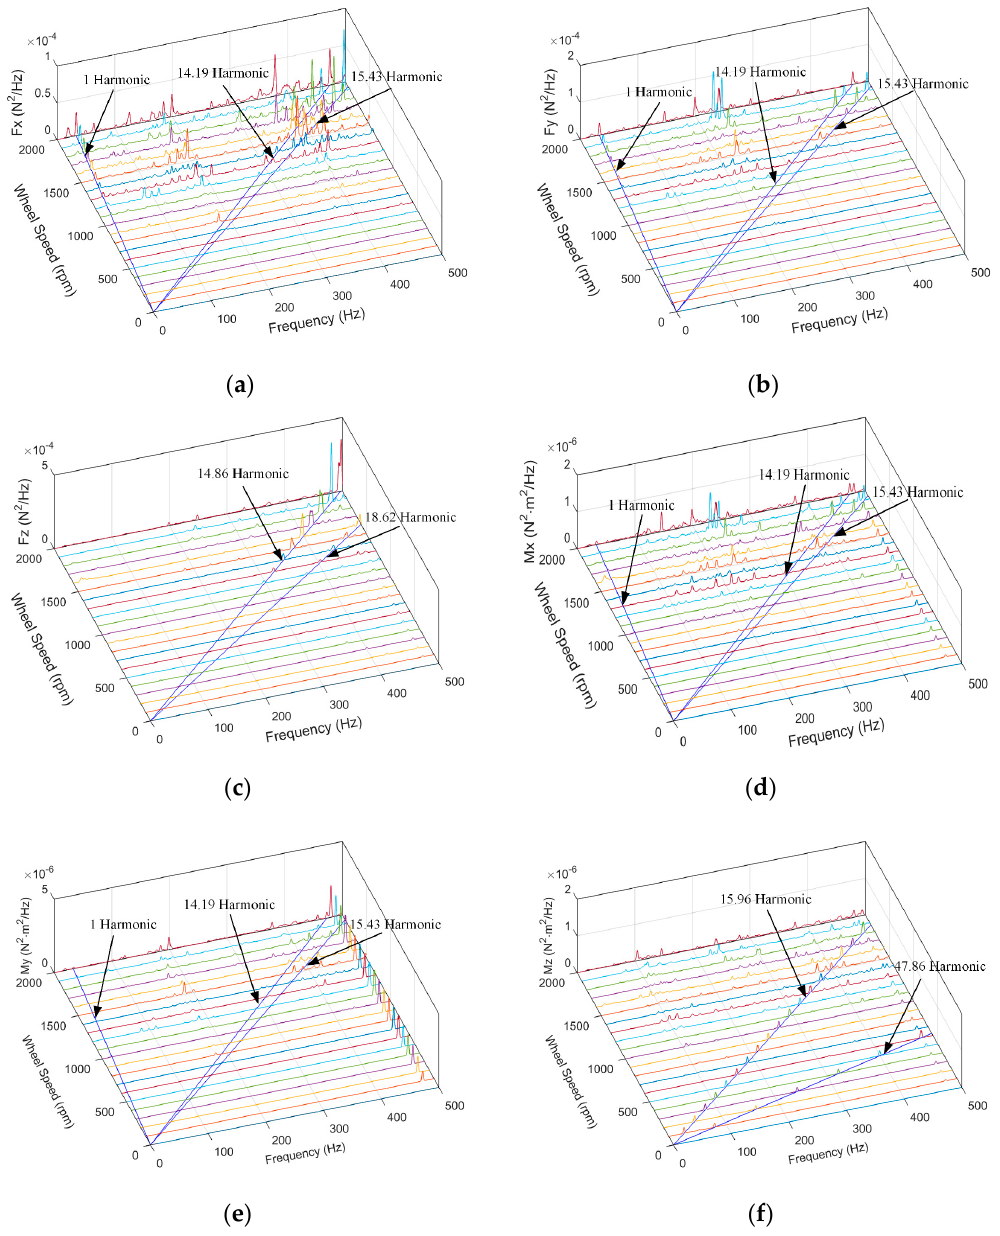
Figure 4. Test site for the RWA disturbance.